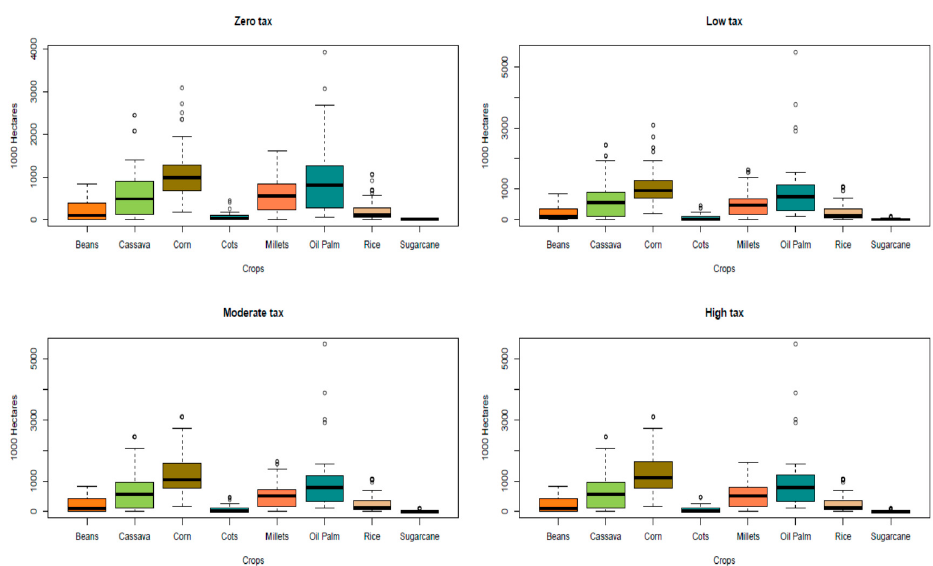
Figure 5. Agricultural crop area by 2050 under no subsidy action.